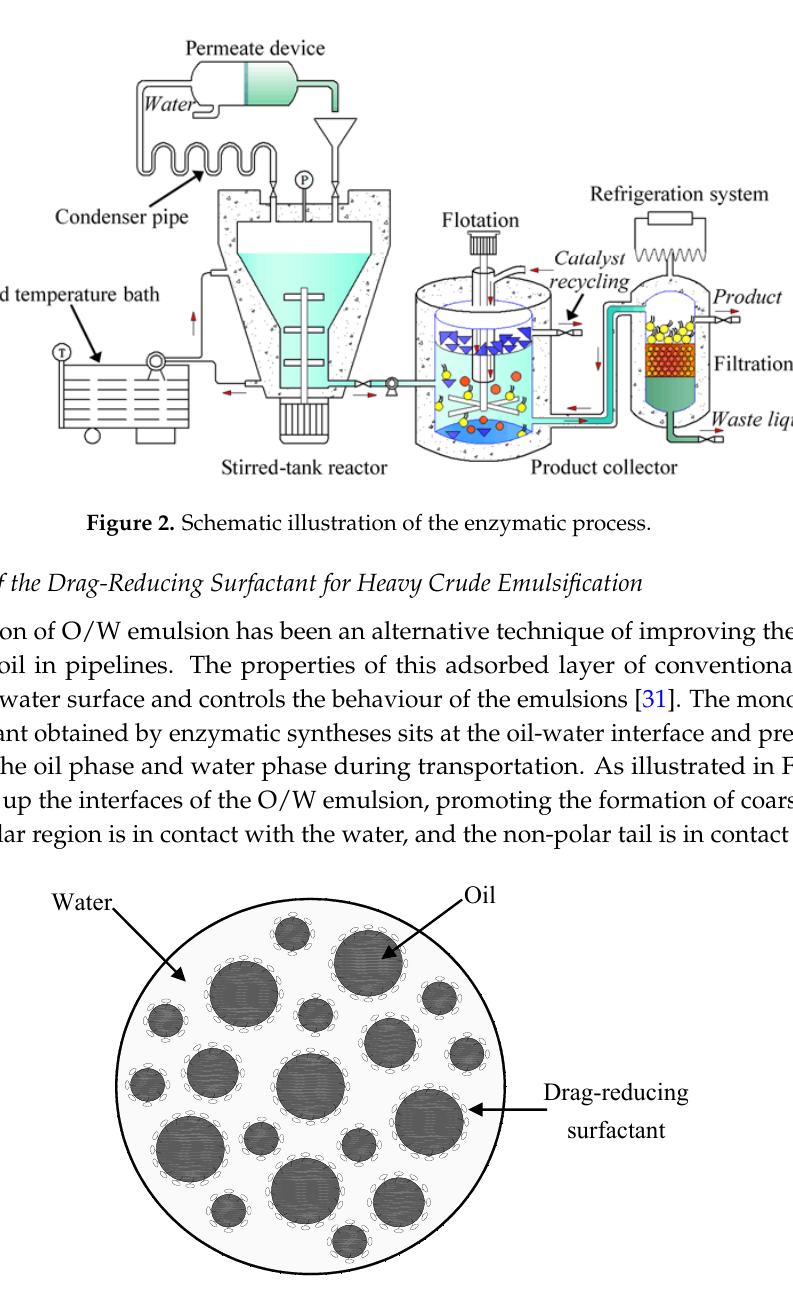
Figure 3. Schematic of the drag ‐ reducing surfactant for heavy crude emulsification.